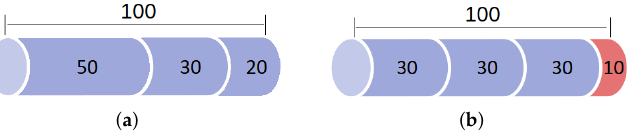
Figure 3. Examples of cutting patterns. The items are drawn in blue and the cut loss is drawn in red. In ( a ), we illustrate the cutting pattern a 2 with cut loss equal to 0 and, in ( b ), the cutting pattern a 4 with cut loss equal to